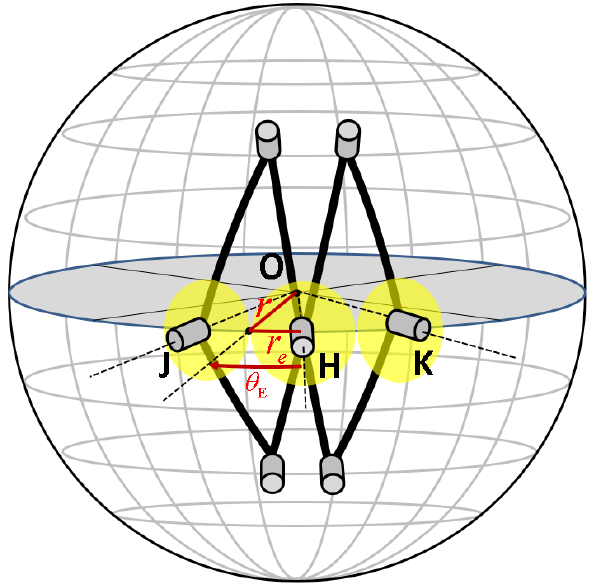
Figure 5. Maximum folded status of the spherical scissor mechanism.